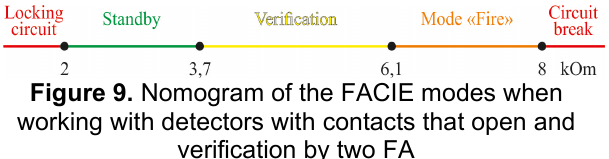
Figure 9. Nomogram of the FACIE modes when working with detectors with contacts that open and verification by two FA